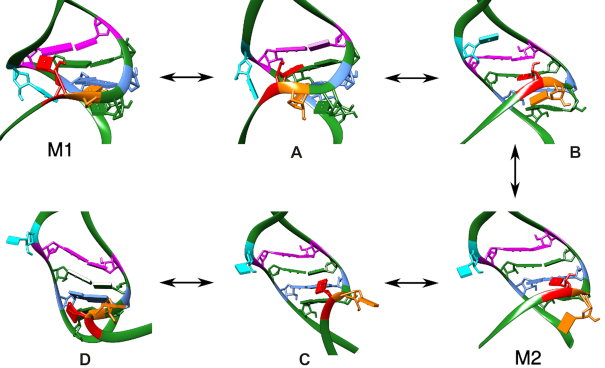
Structures illustrating the key intermediates in the transition from M1 to M2 and M2 to extended structures. In intermediate (a) U40 (red) is no longer found forming T1, forcing U41 downwards and out of T3. U40 can slip further down the strand to form T2 (intermediate b). This structure relaxes to M2. Movement in the lower part of the structure destabilizes T2 (intermediate c), which can lead to the loss of the triplet and formation of extended structures (d).